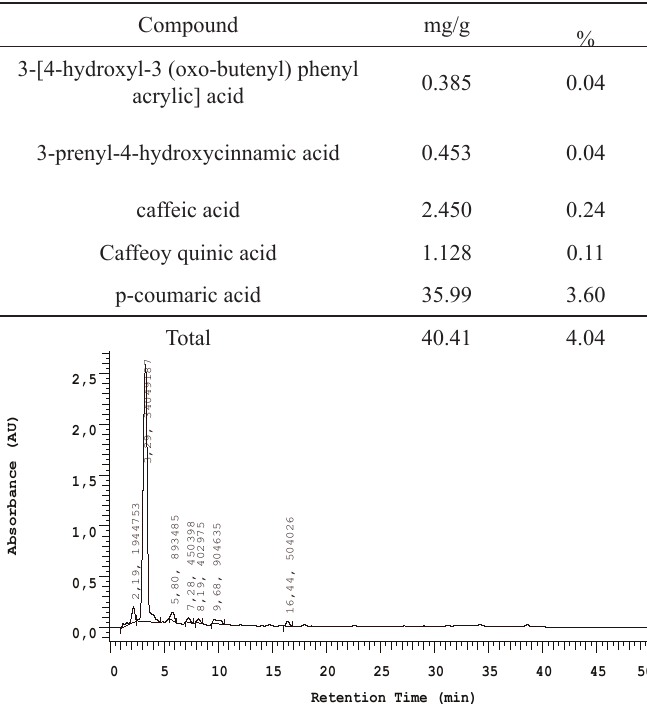
FIGURE 3 - Identification and segmentation of vessels and cells immunostained with calculation of microvessel density: total area occupied by microvessels divided by the total area of the field analyzed.